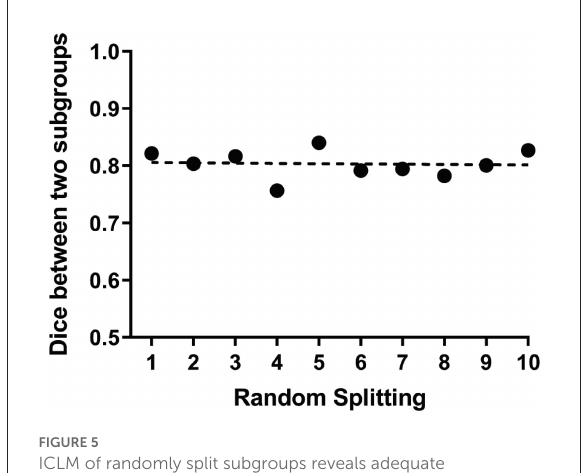
FIGURE5 ICLM of randomly split subgroups reveals adequate reproducibility of this method. The scatter plot shows the dice values between the language networks of the two subgroups extracted in 10 different runs. Each point represents the dice value between two language networks generated by ICLM within two randomly split subgroups. The dotted line indicates the mean value of 10 dice values, which is 0.8, demonstrating the relatively strong reproducibility of